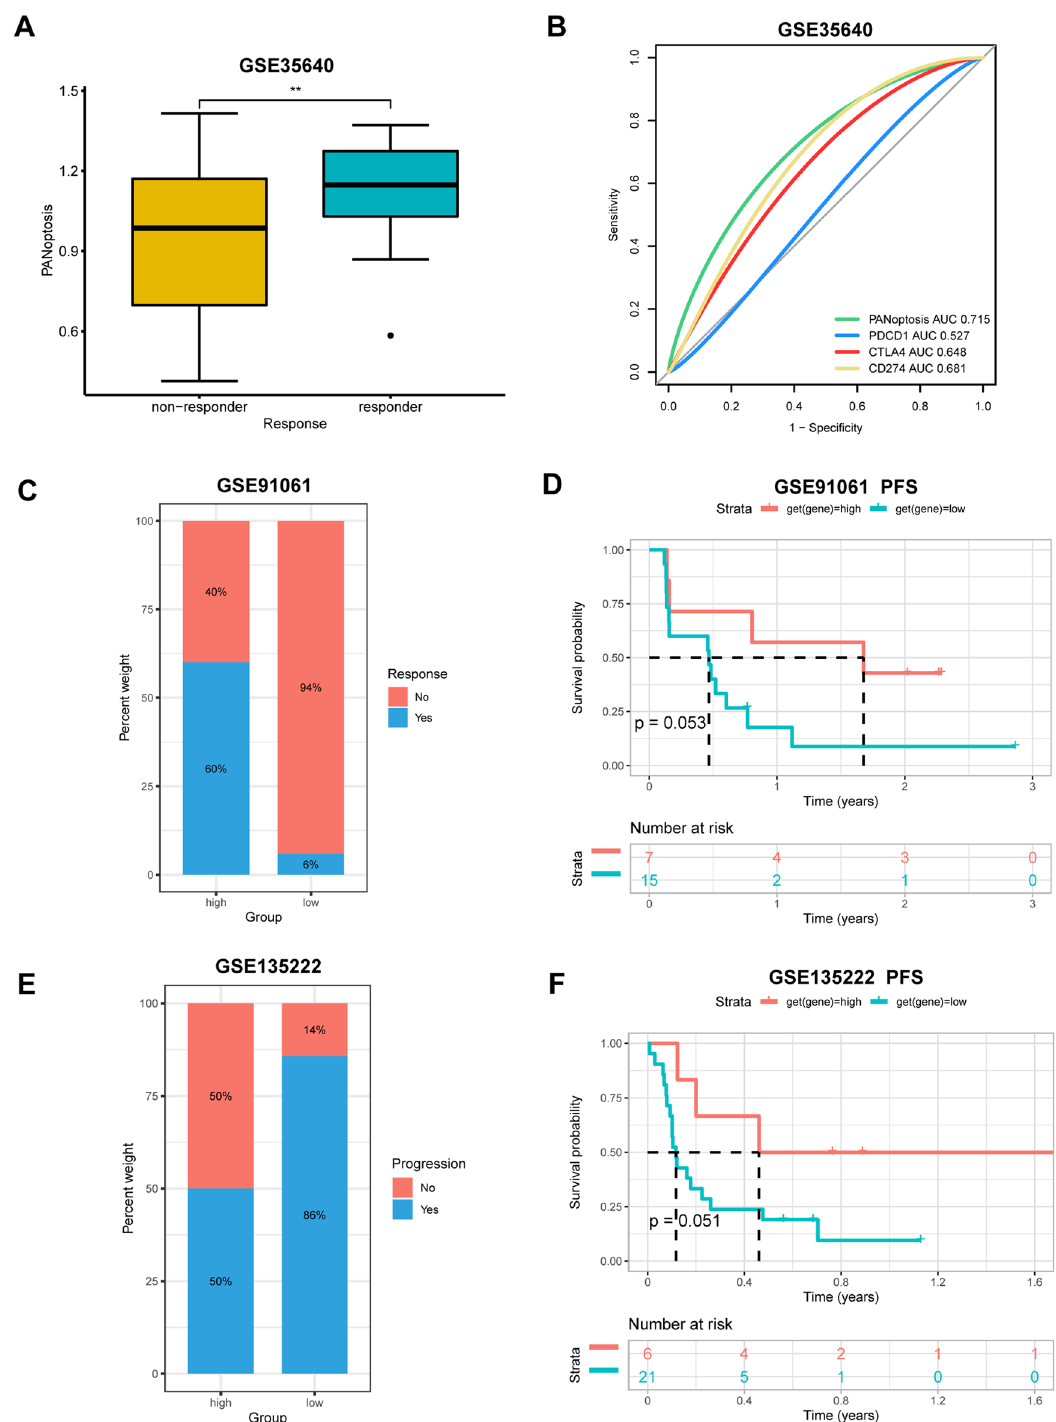
Figure 12. The correlation between PANoptosis score and immunotherapy response. ( A ) The difference of PANoptosis score between immunotherapy responder and non-responder in GSE35640 cohort. ( B ) ROC curve analysis for evaluating the predictive performance on immunotherapy response. ( C , E ) The percentage of responsive and progressive patients in high- and low- PANoptosis score groups in ( C ) GSE91061; ( E ) GSE13522 cohorts. ( D , F ) The Kaplan–Meier PFS analysis of PANoptosis score in ( C ) GSE91061 and ( E ) GSE13522 cohorts. PFS, progression-free survival. ** P <